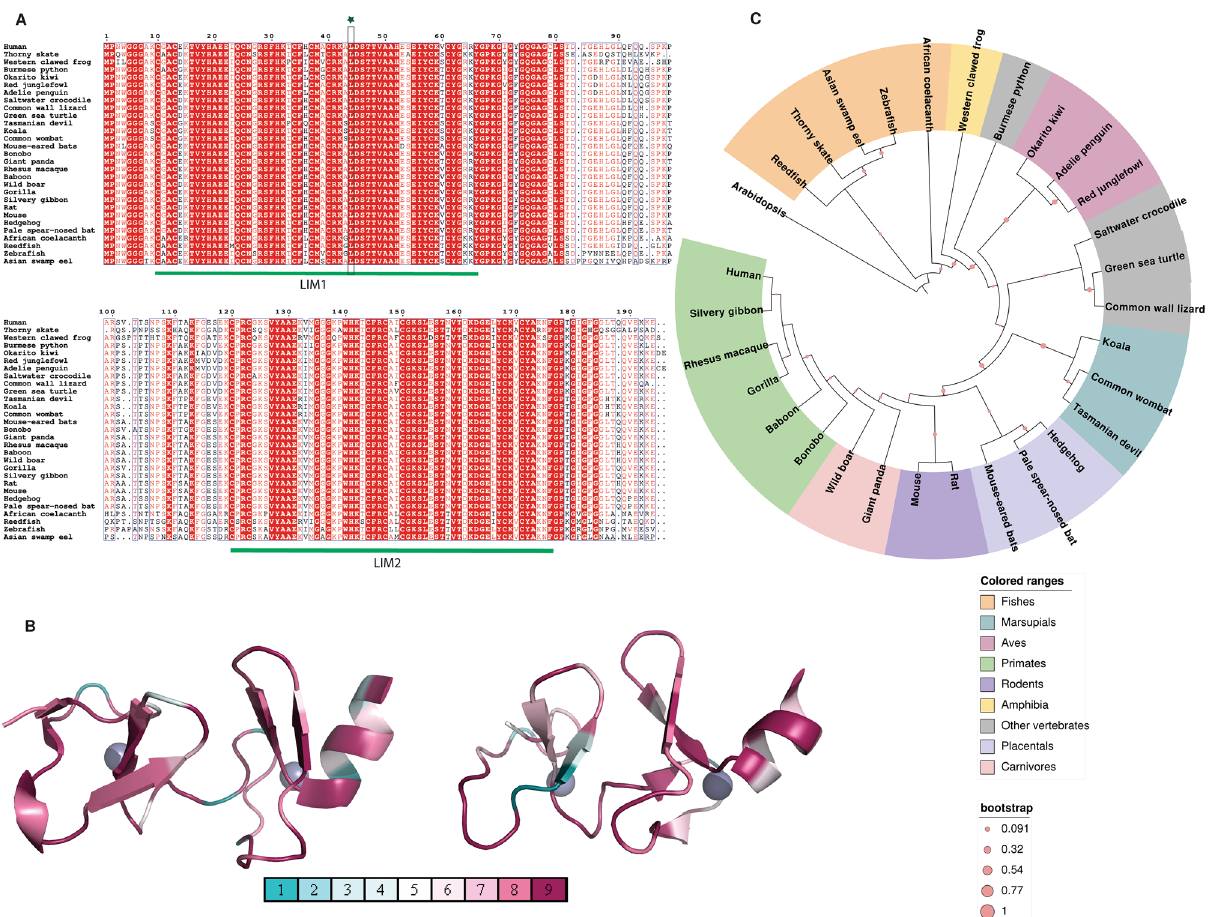
Figure 5. Sequence map of CSRP3 in representative eukaryotes. ( A ) Multiple sequence alignment of CSRP3 proteins from selected eukaryotes. ( B ) Consurf mapping of conserved residues to the structures (left: PDB ID: 2O10; right: PDB ID: 2O13). Blue color shade depict highly variable residue positions (value 1 = highly variable), while dark pink color shade show conserved residues positions (value 9 = extremely conserved). ( C ) Maximum Likelihood Phylogeny of CSRP3 protein in the representative eukaryotes with 1000 bootstrap iterations (pink circles). Different taxa are colored uniquely (see